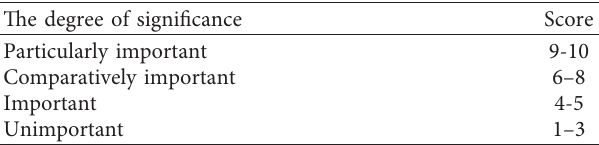
Table 1: Expert scoring criteria of the significance.